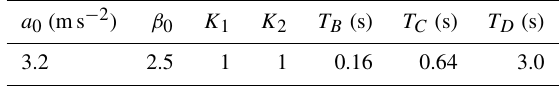
Table 1. Parameters of the input acceleration response spectrum. a 0 (ms − 2